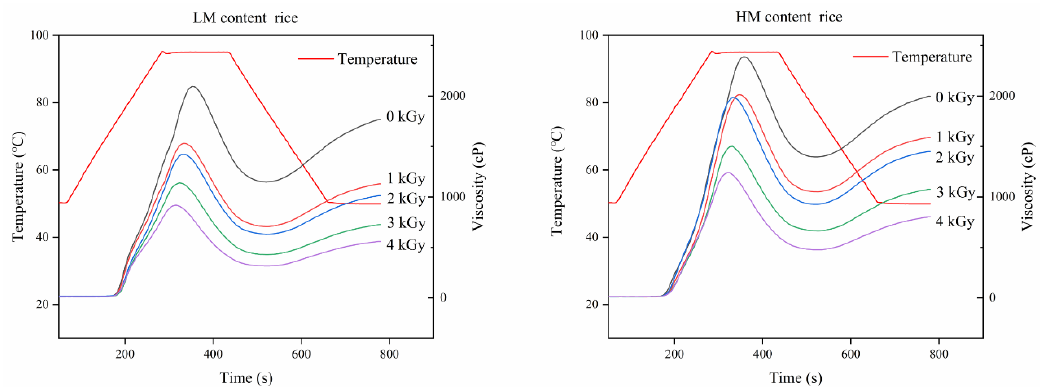
Figure 3. Rapid Visco-Analyzer ( RVA) pasting profiles of LM and HM rice samples under different irradiation doses.